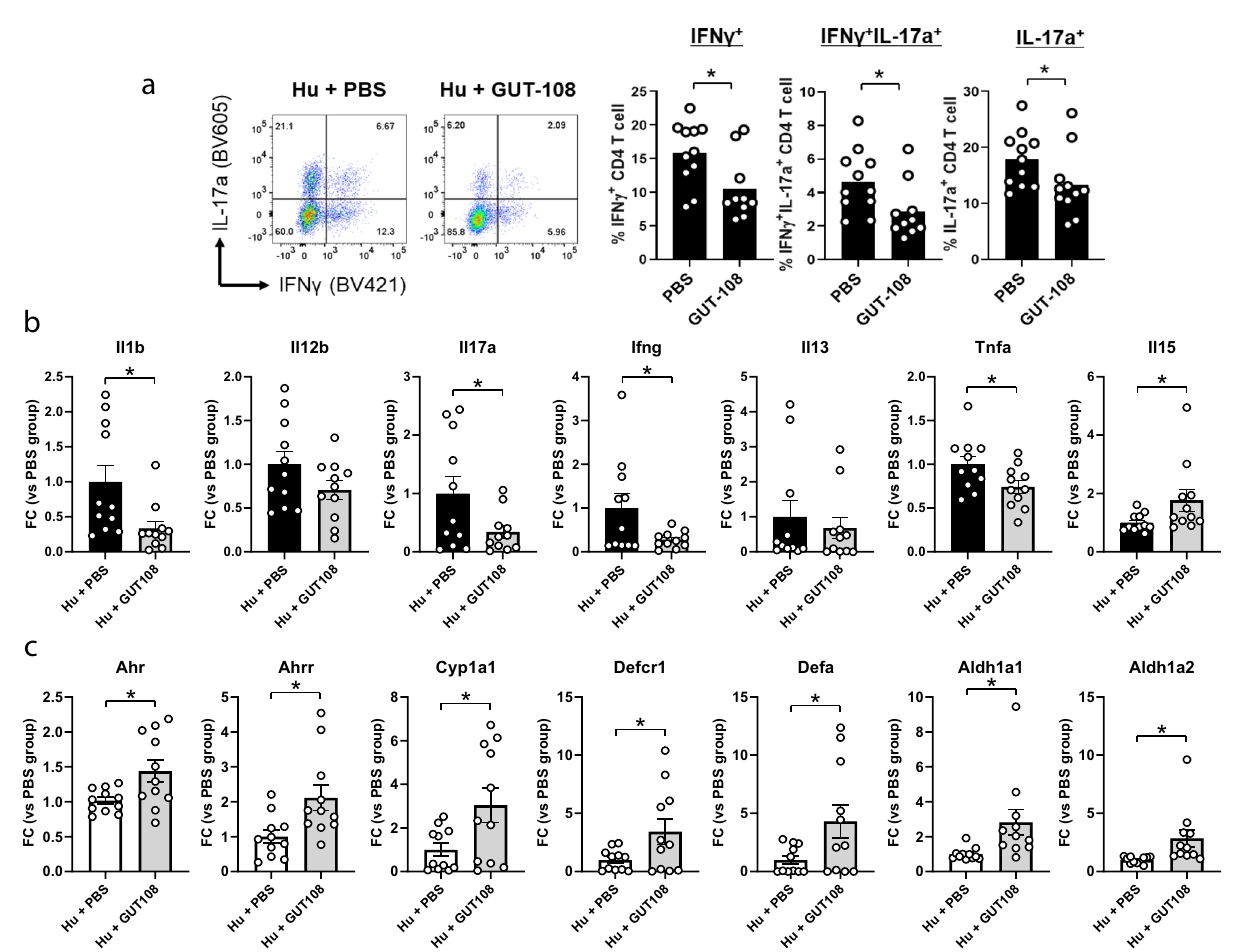
Fig. 5 Effects of treatment with GUT-108 on the levels of in fl ammatory biomarkers. a Colonic lamina propria effector CD4 + T cells, including Th1 and Th17 cells that produce IFN γ and/or IL-17 α . The mRNA expression levels of b in fl ammatory cytokines and c functions important for mucosal homeostasis in the distal colon. Expression levels were determined by RT-Q-PCR and presented as fold change (FC) of expression after therapeutic application of GUT-108 compared to expression after PBS treatment. Hu + GUT-108 refers to humanized Il10 − / − mice treated with GUT-108 2 weeks after fecal colonization; Hu + PBS refers to humanized Il10 − / − mice that received PBS as a placebo control. AhR aryl hydrocarbon receptor gene, AhrR aryl hydrocarbon receptor repressor gene, Cyp1A1 Cytochrome P450 Family 1 Subfamily A Member 1gene, DefCR1 and DefA genes defensins, Aldh1A1 and Aldh1A2 genes aldehyde dehydrogenases. Bar indicates Mean± SE. Two-way ANOVA and adjusted P -value were calculated by the multiple comparisons test. *: adjusted P < 0.05. N = 11/group. Source data and calculated P -values are provided as a Source Data fi le. NATURE COMMUNICATIONS| (2021) 12:3105